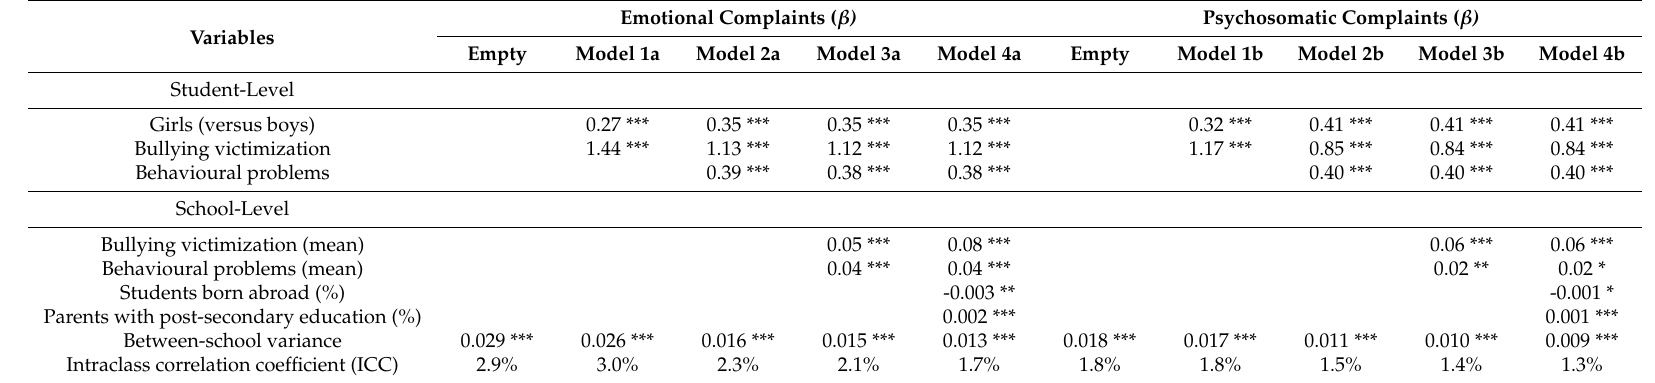
Table 3. Multilevel linear regressions predicting emotional and psychosomatic complaints (59,510 sixth-grade students distributed across 1999